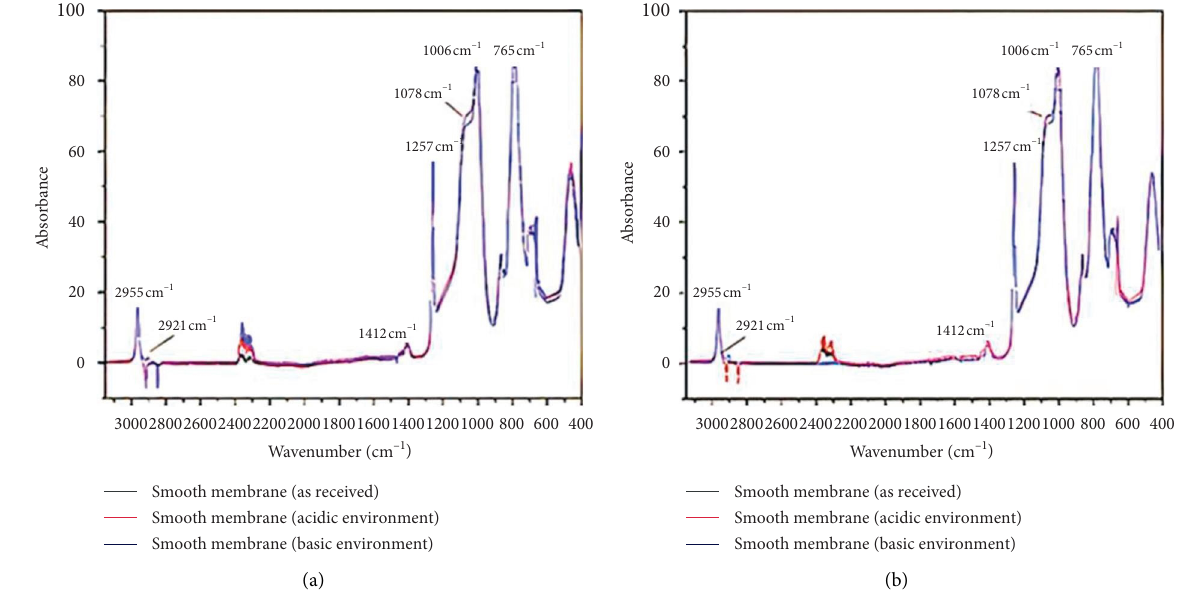
Figure 3: FTIR spectra for (a) smooth and (b) rough membranes before and after degradation studies.